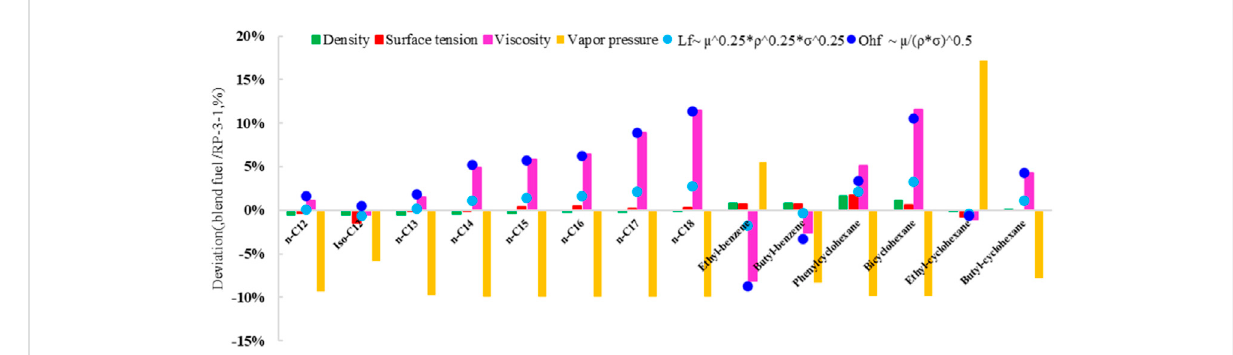
FIGURE 2 Property variations of blending